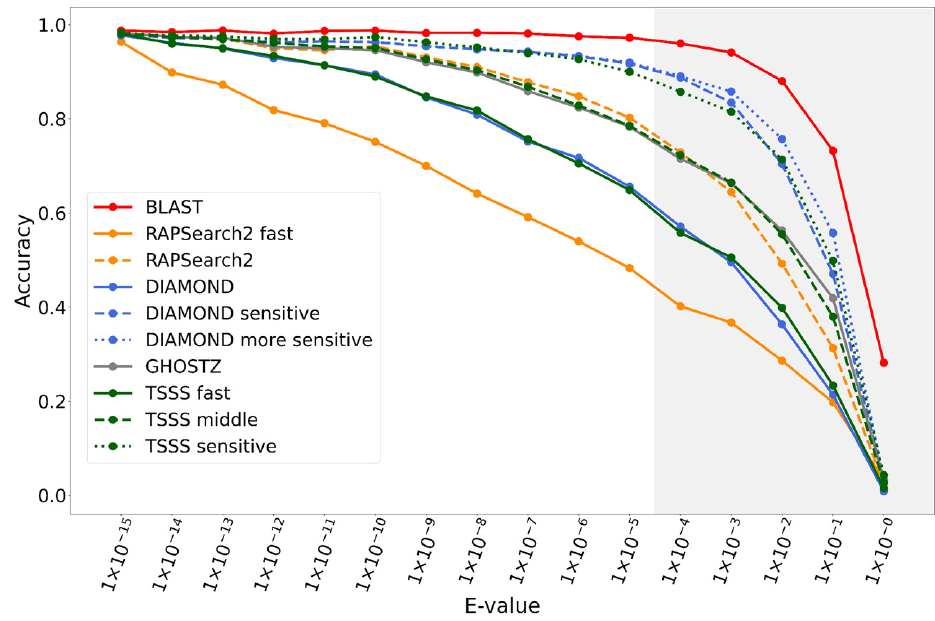
Figure 6. Accuracy of each method according to